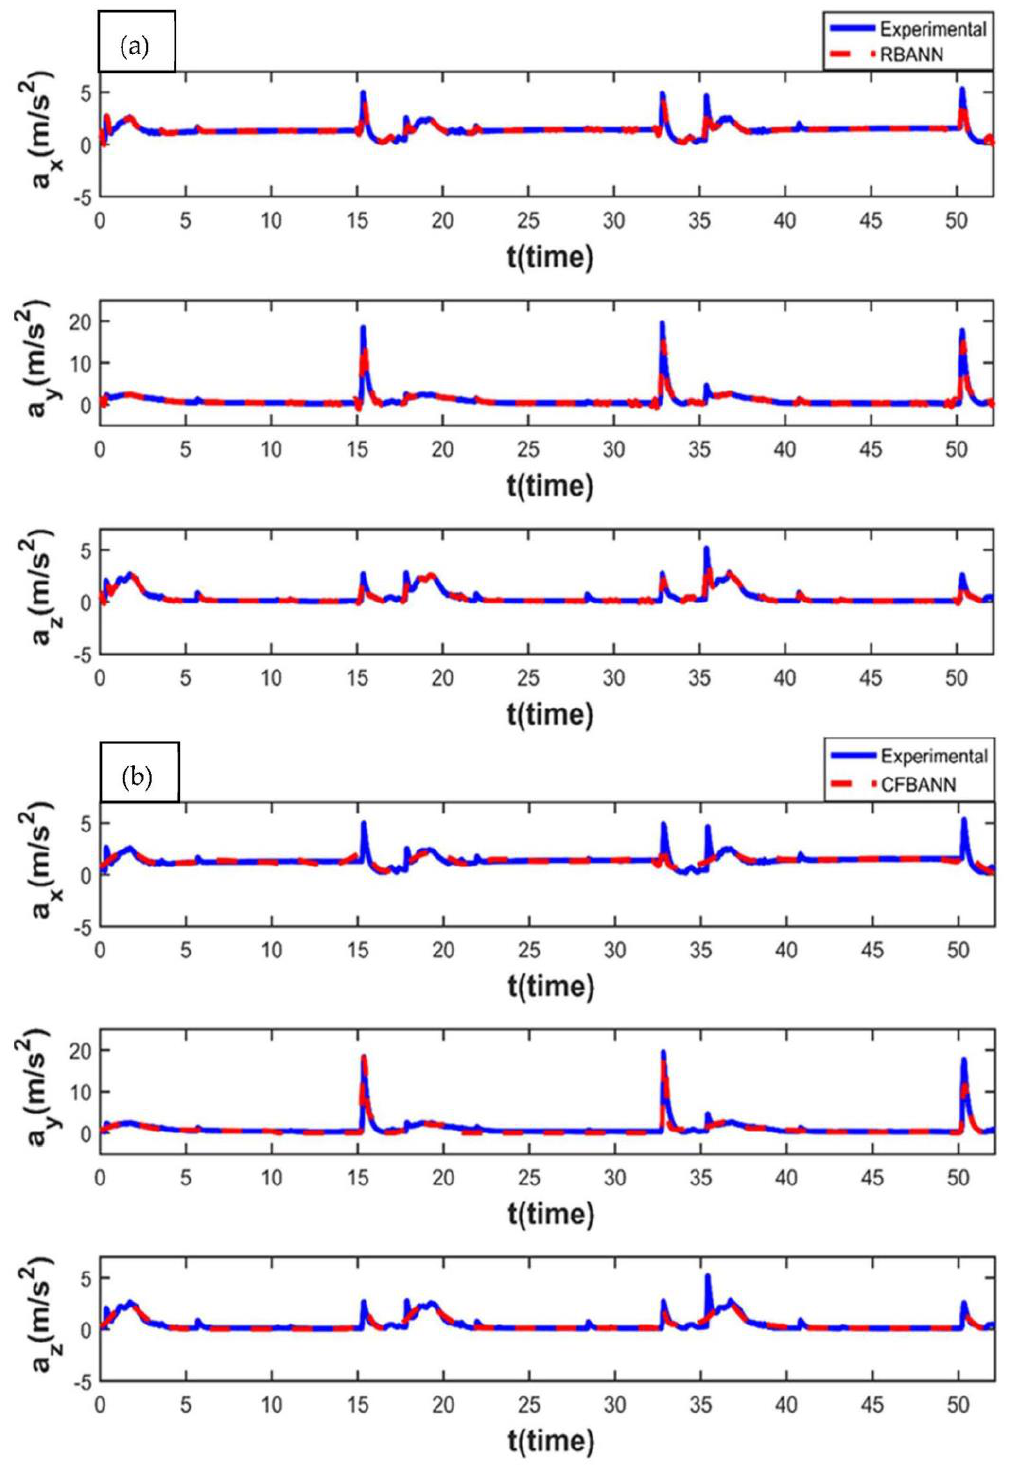
Figure 13. Experimental and ANN results obtained for the working condition of 14 s and 37.5 bar: ( a ) RBANN; ( b ) CFBANN.